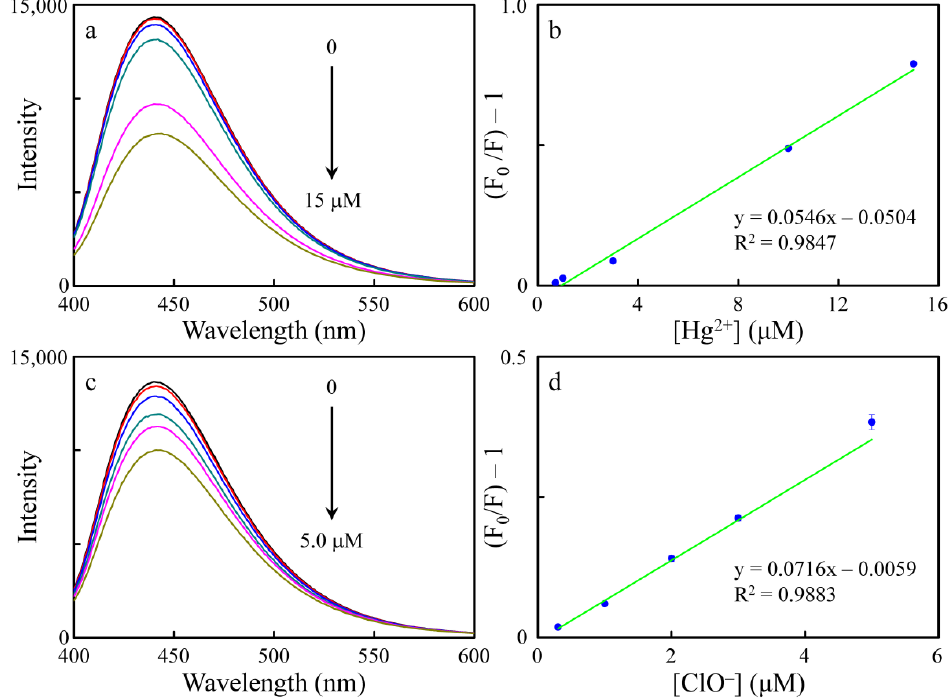
Figure 4. ( a ) Fluorescence emission spectra for the NSCDs in the presence of different concentrations of Hg 2+ . ( b ) Linear relationships between fluorescence intensity and concentrations of Hg 2+ in the range of 0.7–15 µ M. ( c ) Fluorescence emission spectra for the NSCDs in the presence of different concentrations of ClO – . ( d ) Linear relationships between fluorescence intensity and concentrations of ClO – in the range of 0.3–5 µ